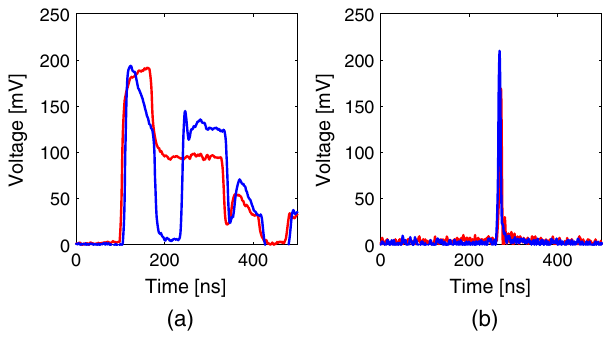
excited in acc FIG. 13. Pulse waveform of typical breakdown event with current flash at flat top pulse width of 250 ns. (a) Directional coupler signals. The red curve is the incident microwave signal and the blue curve is the reflected microwave signal. (b) Faraday cup signals. The red curve is the signal of the power feed end and blue curve is the signal of the power cut end.